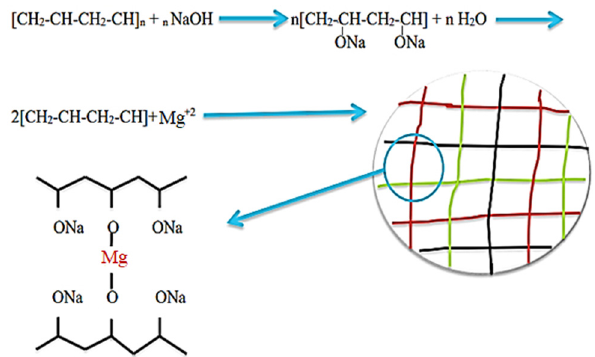
Figure 4: Mg - PVA SAP